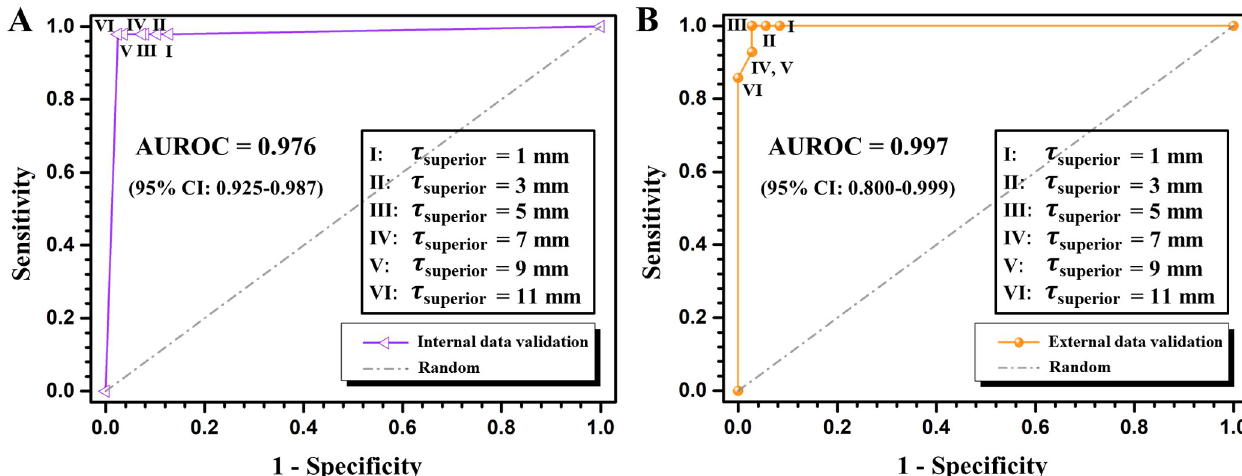
Fig 4. ROC curve and AUROC values for internal (A) and external data (B), respectively.